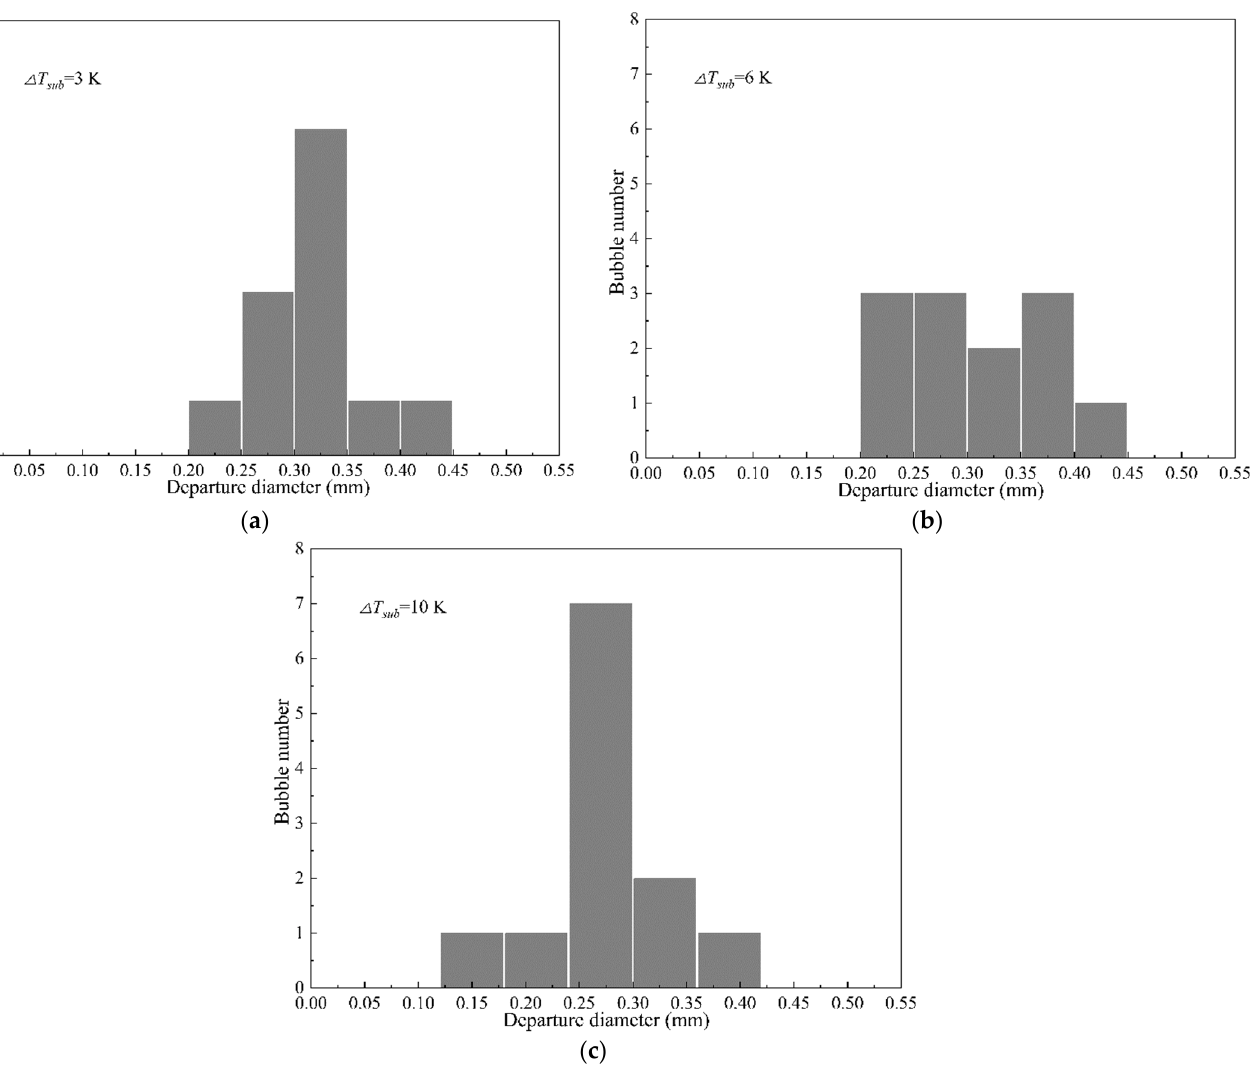
Figure 14. Bubble departure diameter at different inlet subcooling, ( q = 0.3 MW/m 2 , V = 0.4 m/s): ( a ) bubble departure diameter at inlet subcooling of 3 K; ( b ) bubble departure diameter at inlet subcooling of 6 K; ( c ) bubble departure diameter at inlet subcooling of 10